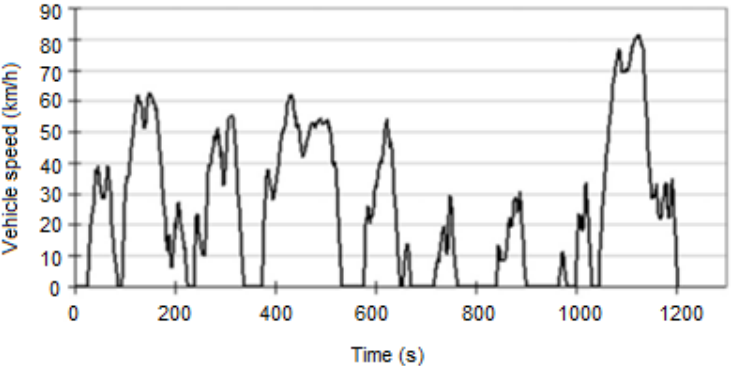
Figure 8. Evolution of speed versus time for the 10–15 protocol [4] (Reproduced with permission from Huicui et al. [4], Applied Energy; published by Elsevier Ltd., 2018).